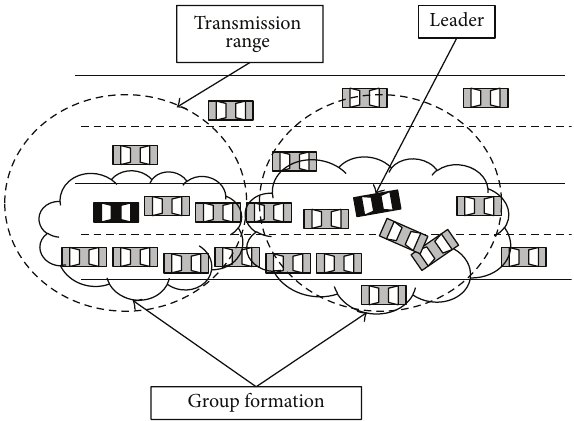
Figure 1: Group formation and leader